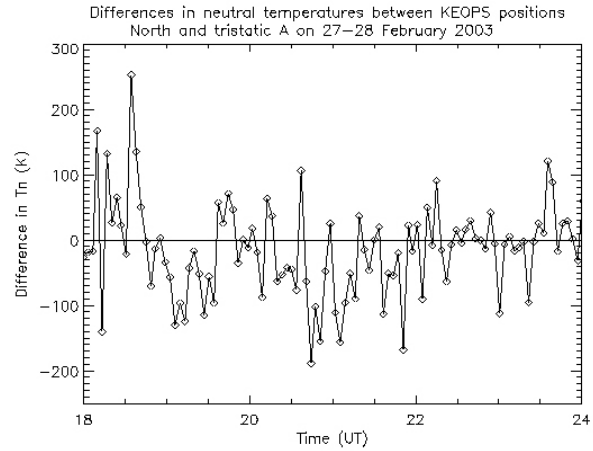
Fig. 7. (c) Percentage contribution of the neutral wind dynamo to Joule heating on the night of 27–28 February 2003.